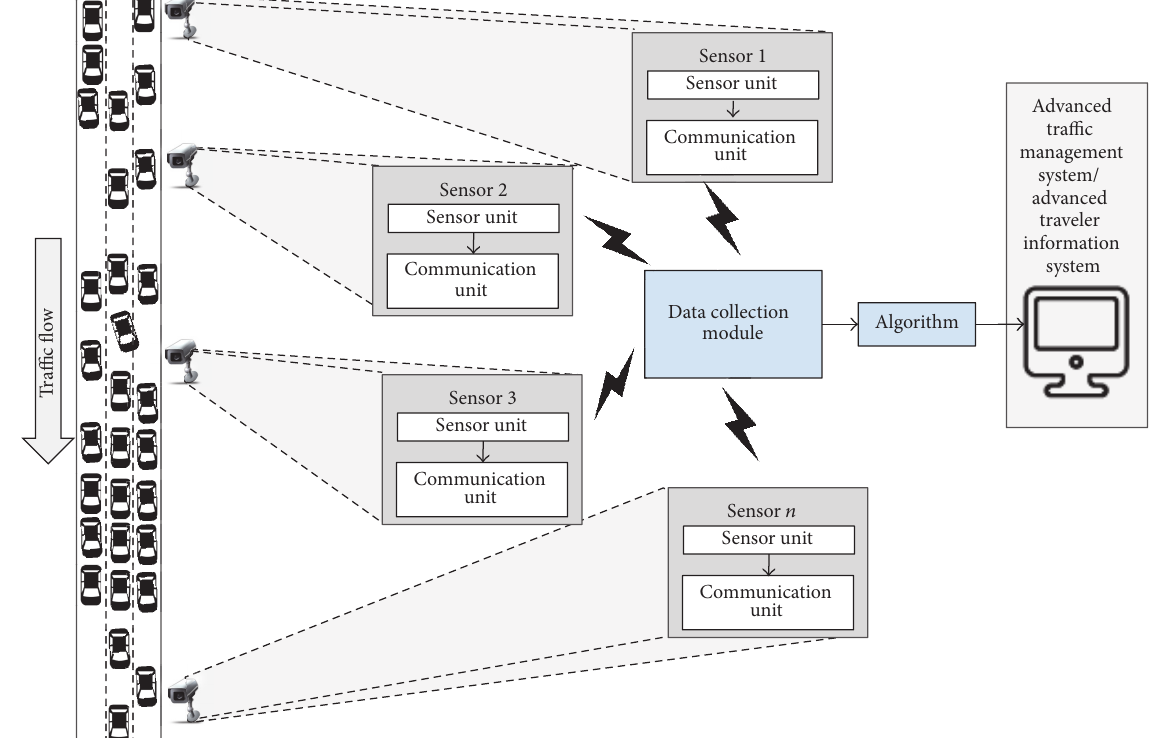
Figure 1: How the proposed algorithm can be deployed with roadside sensors on a freeway segment. The proposed algorithm is the algorithm module which uses traffic data collected from sensors to detect anomalies and estimate